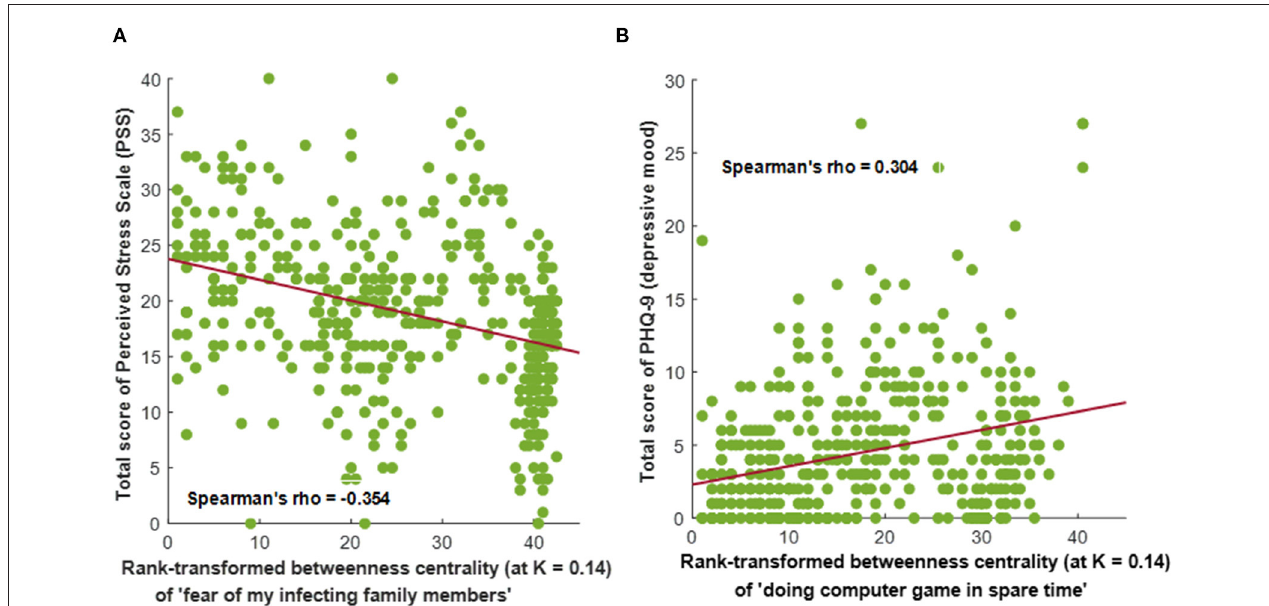
FIGURE 3 | Significant correlations between the intensity of perceived stress or depressive mood vs. rank-transformed betweenness centralities of personal attitudes or changes in lifestyle during the COVID-19 pandemic among Korean medical students ( n = 454; statistical threshold of |Spearman’s rho| > 0.3 and P < 0.001). Values of rank-transformed betweenness centrality were calculated from the intra-individual covariance networks (at network sparsity level of K = 0.14) containing the changes in lifestyle, personal attitudes, perceived stress, anxiety, and depressive mood. (A) Correlations between the total score of perceived stress scale (PSS) vs. rank-transformed betweenness centrality values of “personal attitude, fear of infecting my family members” (Spearman’s rho = − 0.354, P < 0.001). (B) Correlations between PHQ-9 (depressive mood) total score vs. rank-transformed betweenness centrality values of “engaging in computer games in spare time” (Spearman’s rho = 0.304, P <